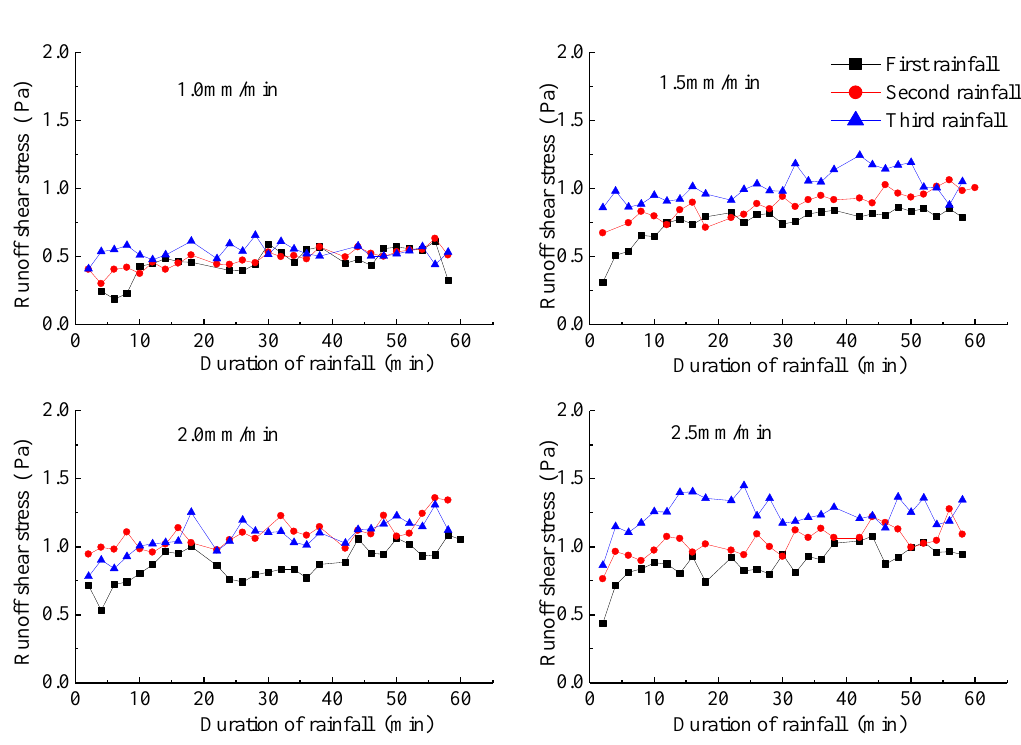
Figure 16. Variation curve of runoff shear stress with time of the loess slope at different rainfall densities.